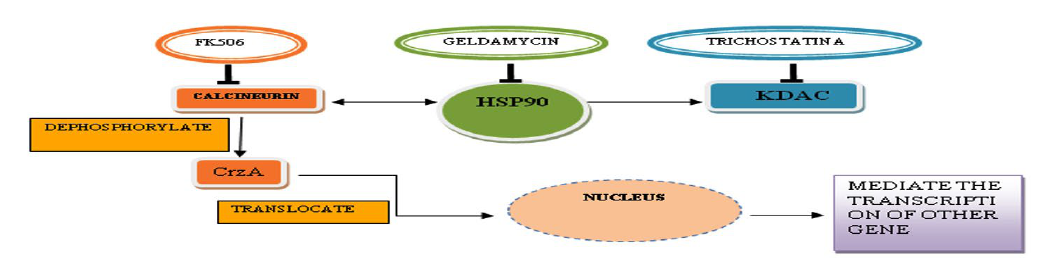
Fig. 4. Hsp90-calcineurin